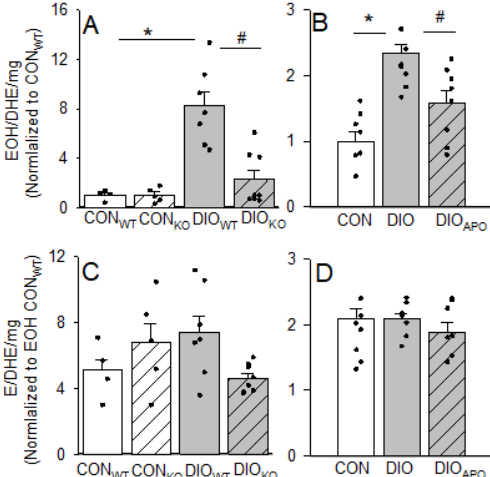
Figure 1. Reactive oxygen species-products hydroxyethidium (EOH) and ethidium (E) per dihydroethidium (DHE) consumed in cardiac tissue from lean controls (CON WT and CON KO ) and obese (DIO WT and DIO KO ) wild type and NOX2 KO mice fed a high fat diet for 28 weeks ( A , C ). Also shown in lean (CON), obese (DIO), and apocynin-treated obese (DIO APO ) C57BL / 6J mice fed a western diet for 28 weeks ( B , D ) n = 4–8 in each group. Values are normalized to EOH in lean controls. Single values and means ± SEM. * p < 0.05 CON vs. DIO within same genotype, # p < 0.05 DIO WT vs. DIO KO and DIO vs. DIO APO .